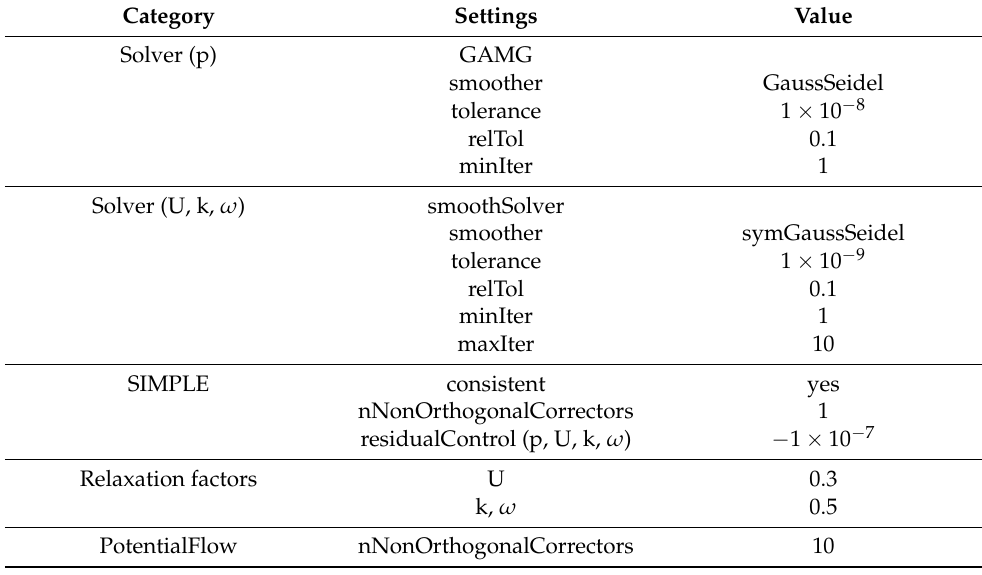
Table 2. OpenFOAM solver control settings, adapted from